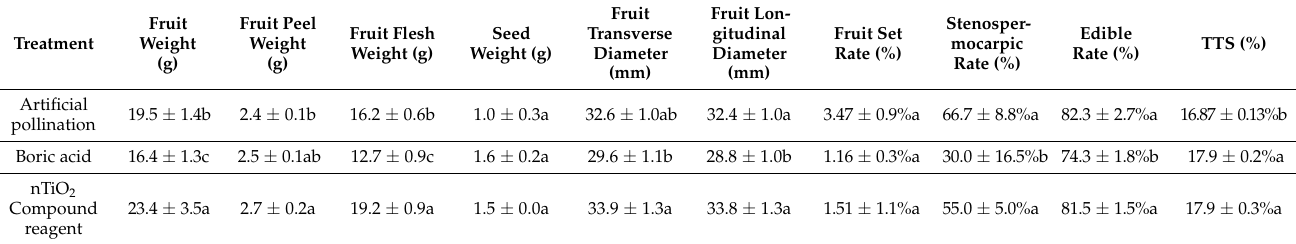
Table 3. Artificial pollination of ‘Guiwei’ fruit quality under different